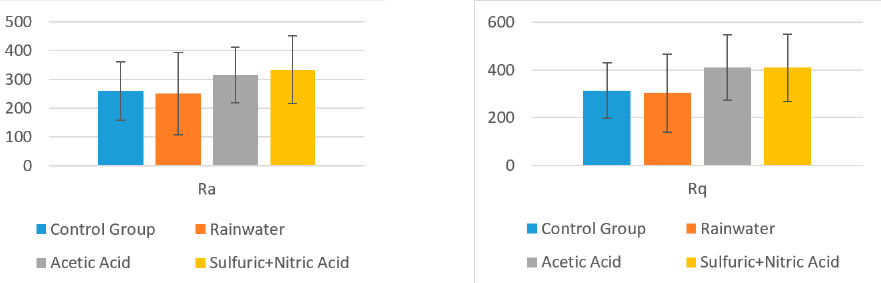
Figure 9. Mean values for Ra and Rq and their standard deviations in different solvents for struc- tural layer.